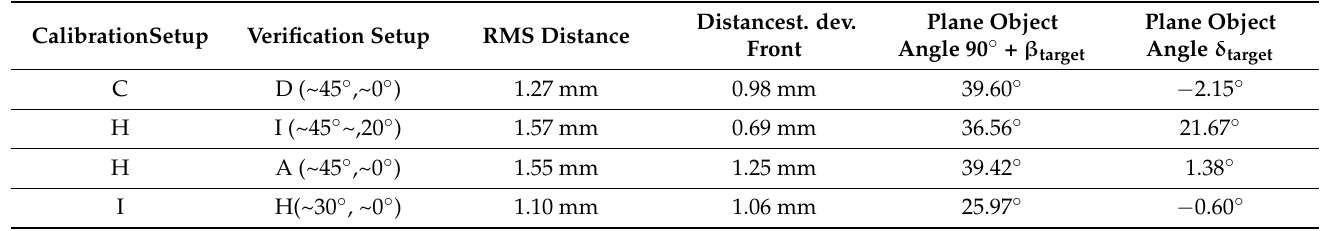
Table 5. Verification results for the three successful calibration setups (C, H, I). The column with the verification setup also shows the approximate real angles of the used plane object. The RMS distance variation of the point cloud data on the plane object is given after the verification run. Additionally, the resulting orientation angles of the plane object of the verification run are given. (The plane object used for the verification runs was the same as the calibration plane object used for the calibration